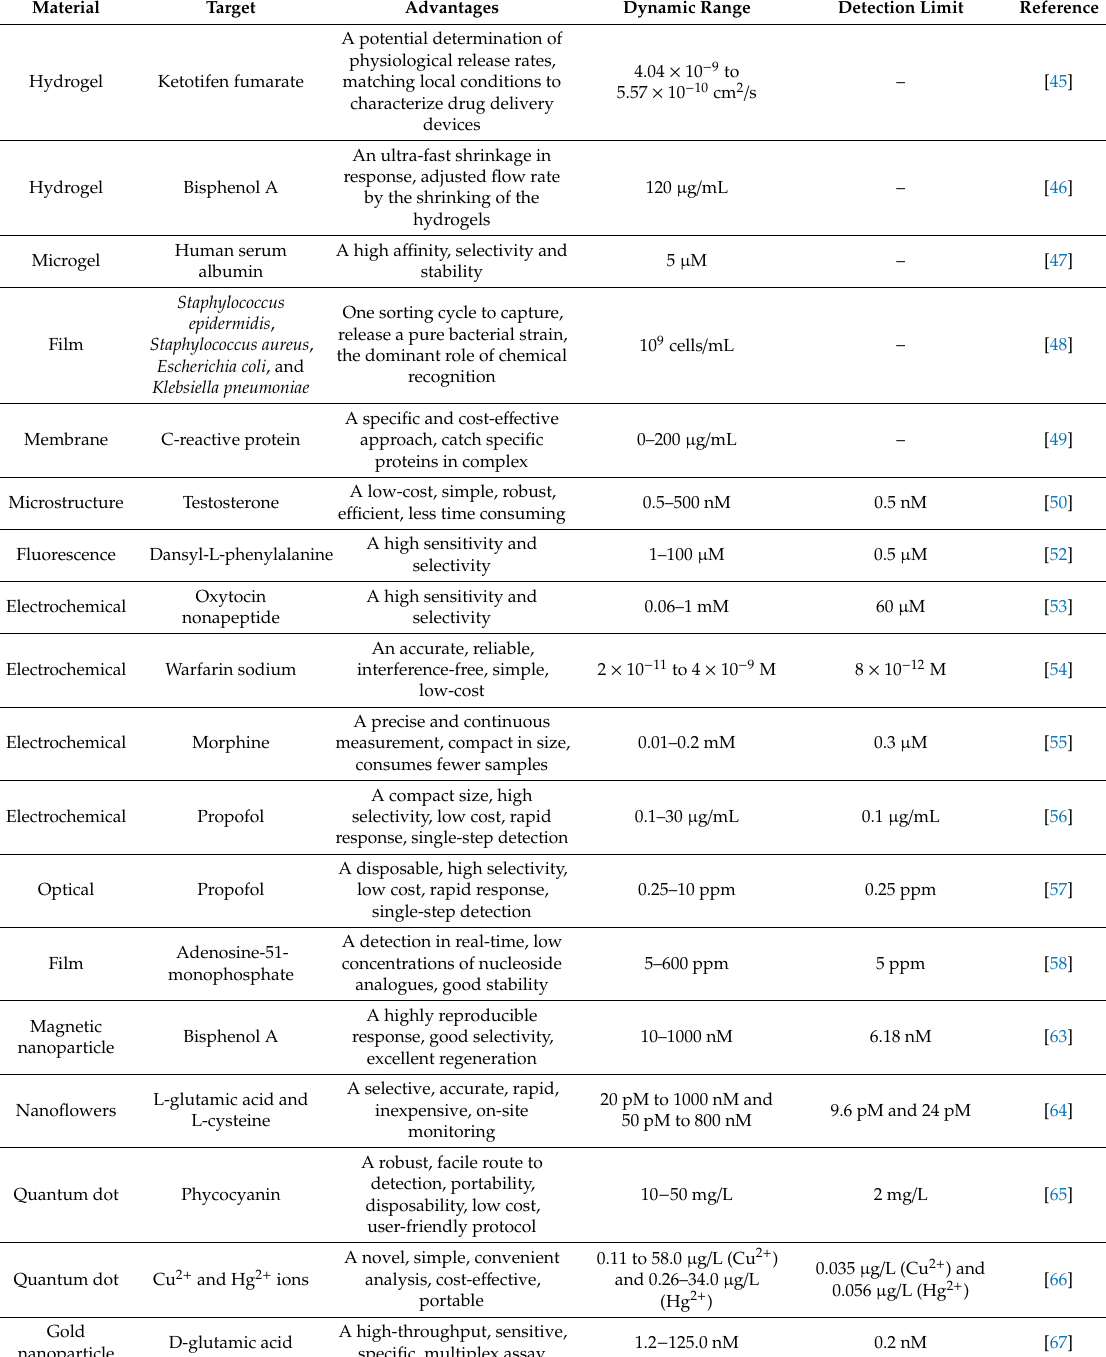
Table 1. Summary of the recent MIP-based microfluidic